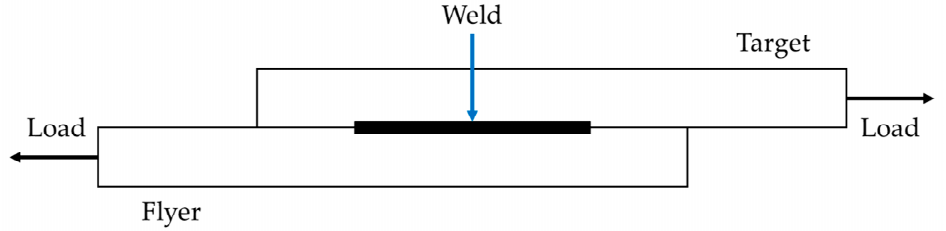
Figure 7. Schematic of the lap shear test.